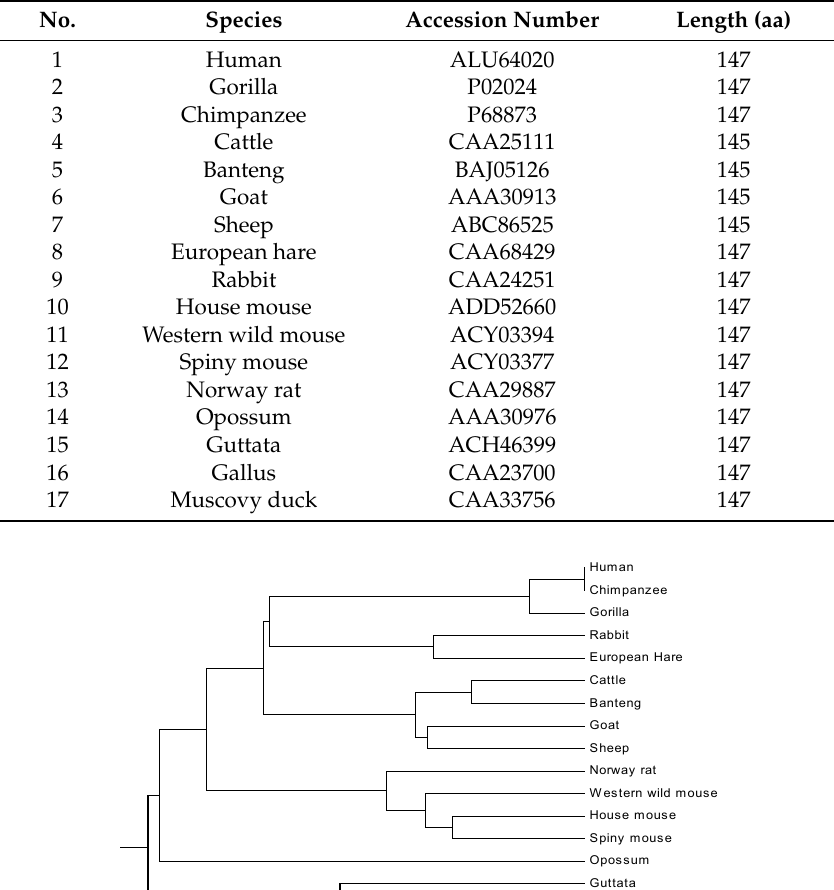
Table 4. The β‐ globin protein of 17 species. Table 4. The β -globin protein of 17 species.